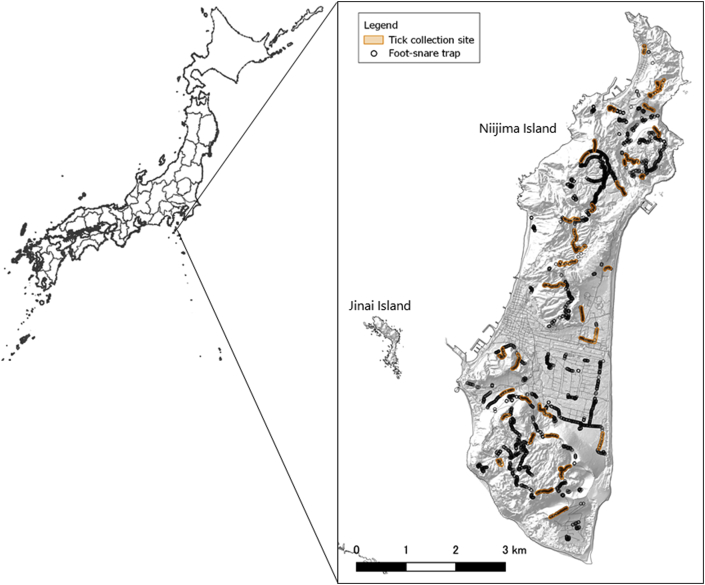
Map of Niijima Island, with locations of foot snare traps (black circle), and tick collection routes for the tick survey conducted June, August, and November of 2018 and February of 2019 (orange area). (For interpretation of the references to colour in this figure legend, the reader is referred to the Web version of this article.)